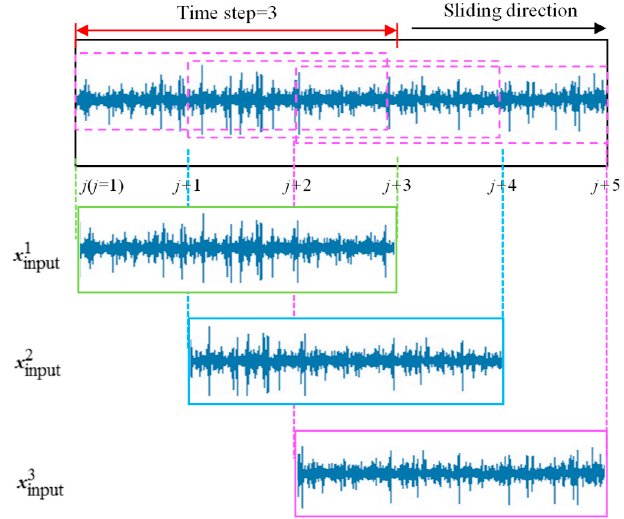
Figure 7. Illustration of time-window embedding.